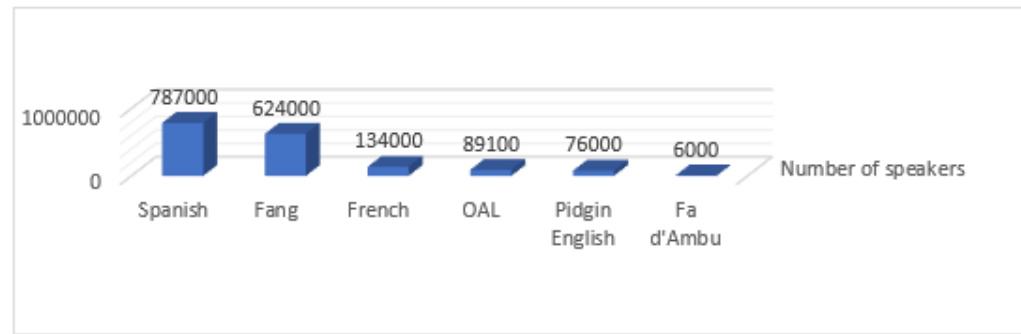
Figure 1. Number of Language Speakers in Equatorial Guinea. Source: Ethnologue (Simons and Fennig 2018). The breakdown of other autochthonous languages [OAL] is shown in Table 1.